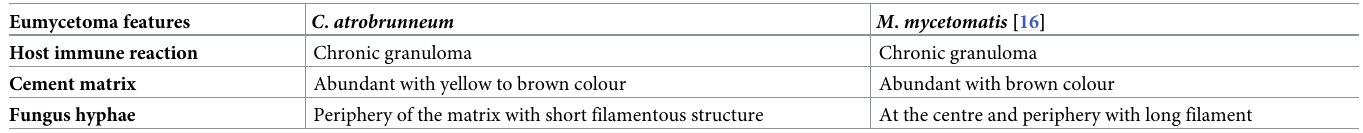
Table 1. The different characteristic features of C . atrobrunneum and M . mycetomatis . Eumycetoma